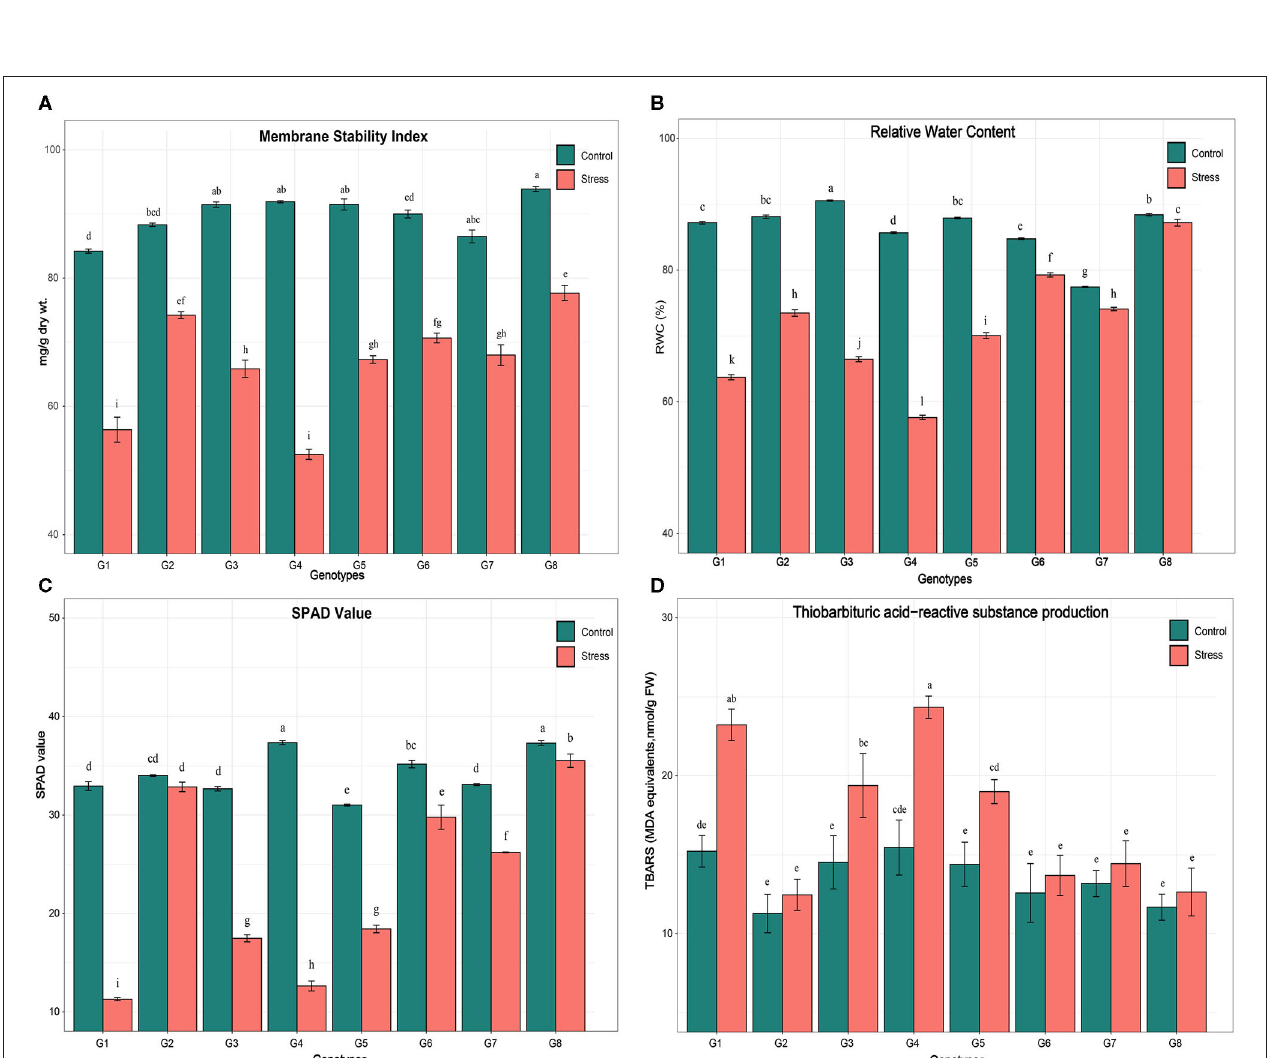
Frontiers in Plant Science |